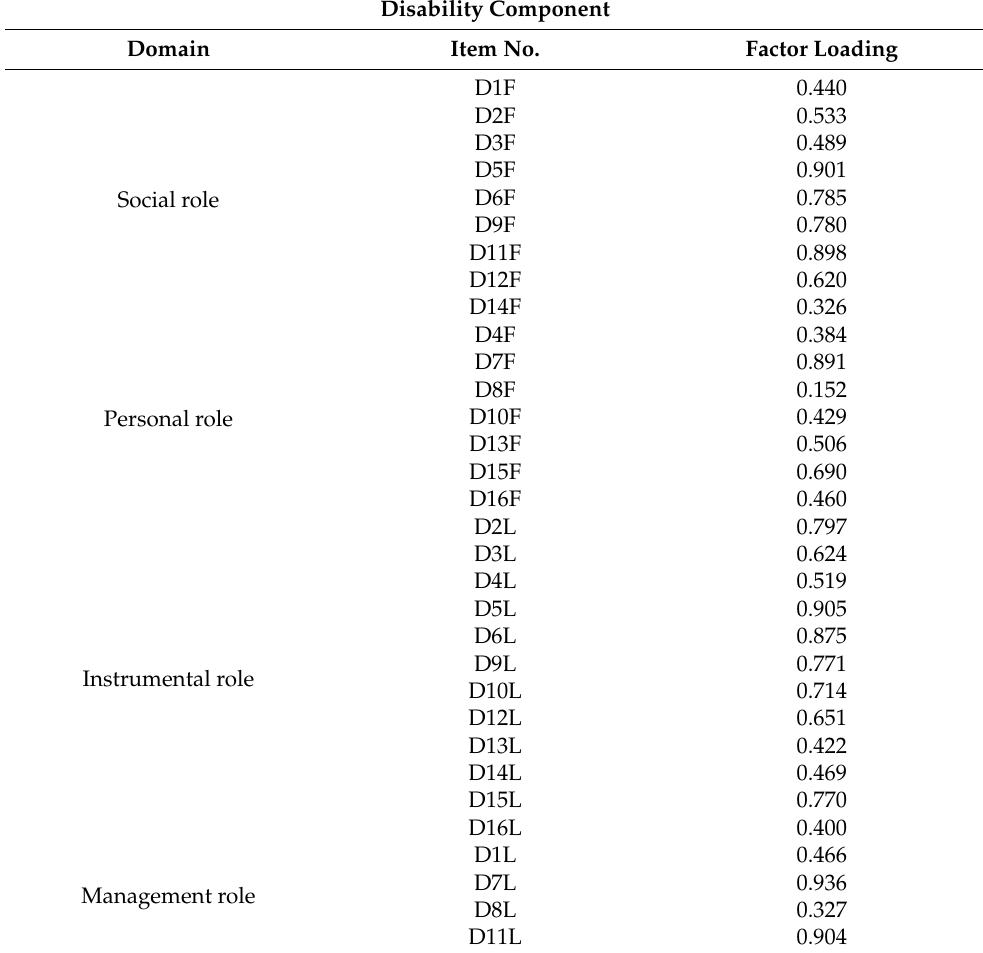
Table 4. Factor analysis for the Disability component of the K-LLFDI four domains.